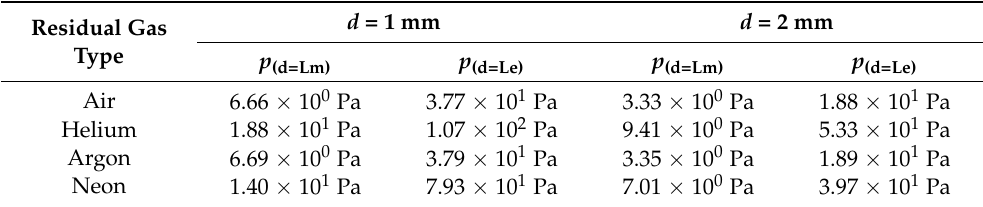
Table 1. Summary of pressure values at which the mean free paths of electrons and molecules equal the contact gap tested.